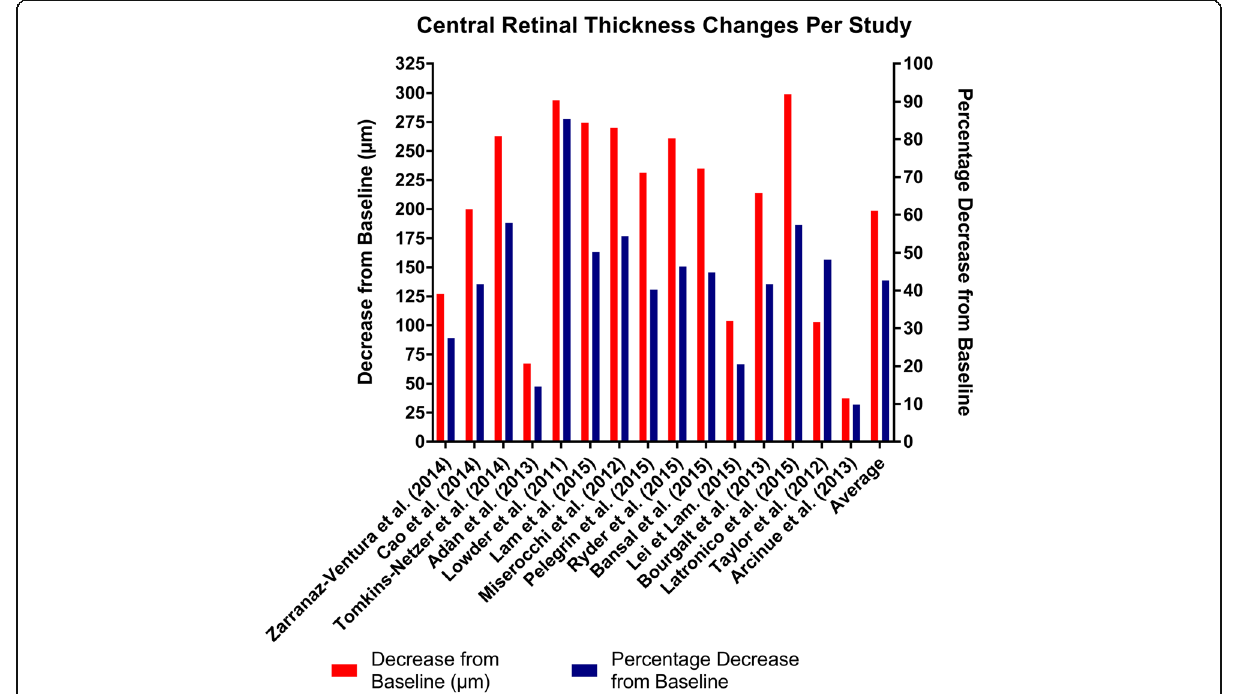
Fig. 2 Central retinal thickness